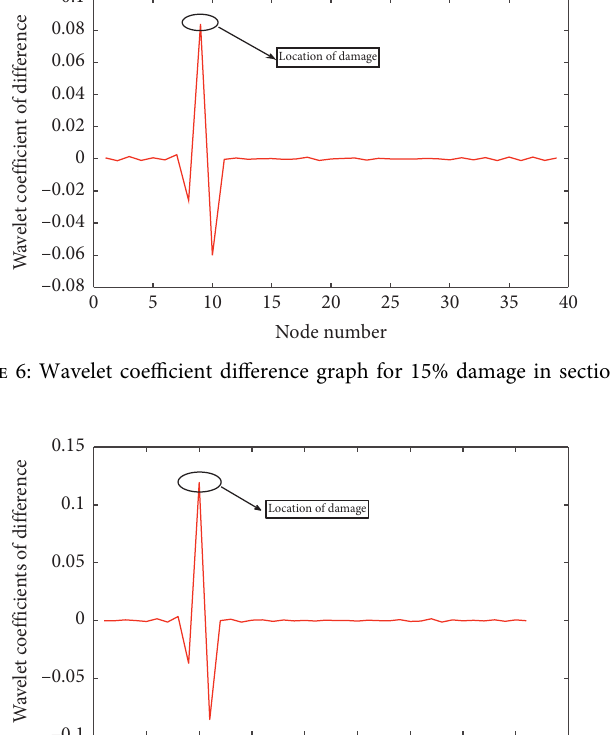
Figure 7: Wavelet coefficient difference graph for 20% damage in section 9.